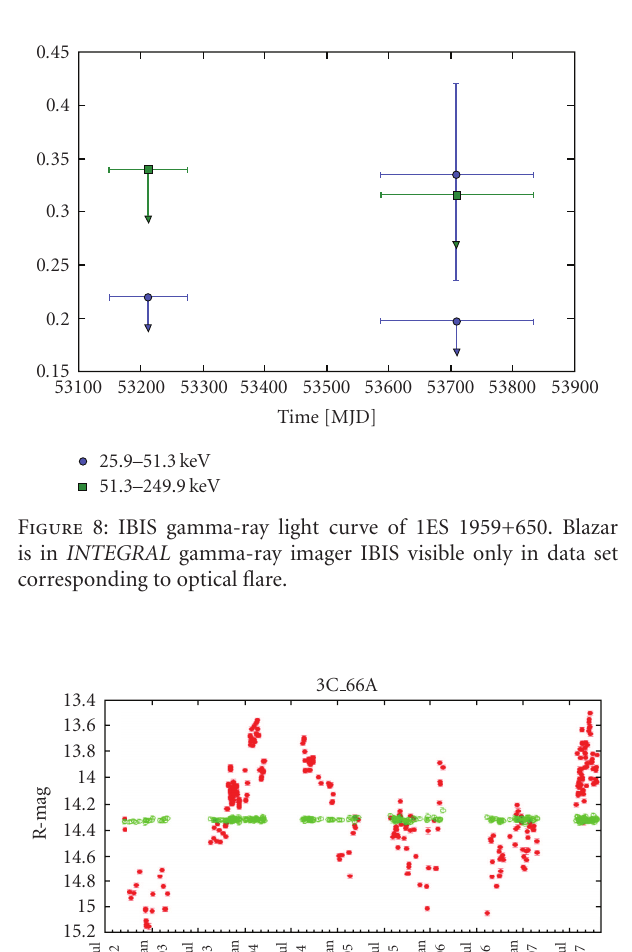
Figure 9: Optical light curve of blazar 3C66A (in red, Tuorla Observatory blazar monitoring program). The green symbols represent the control measurement of constant